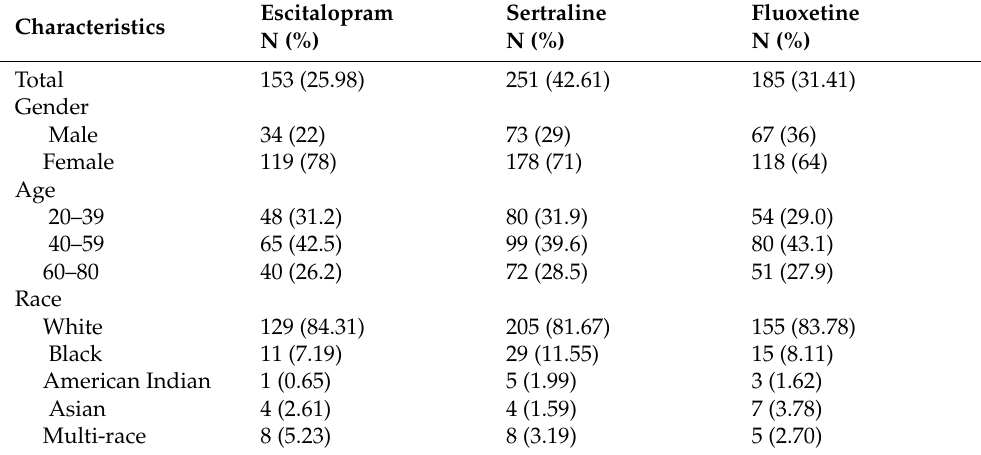
Table 1. Demographic characteristics of study participants on the various